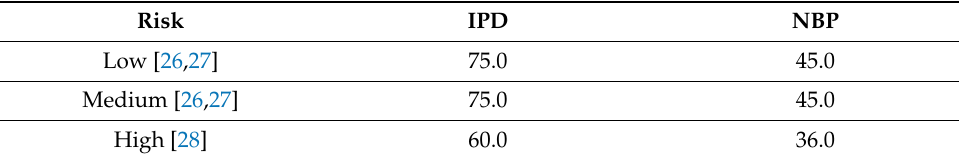
Table 7. Initial vaccine efficacy 65–74 age group (%